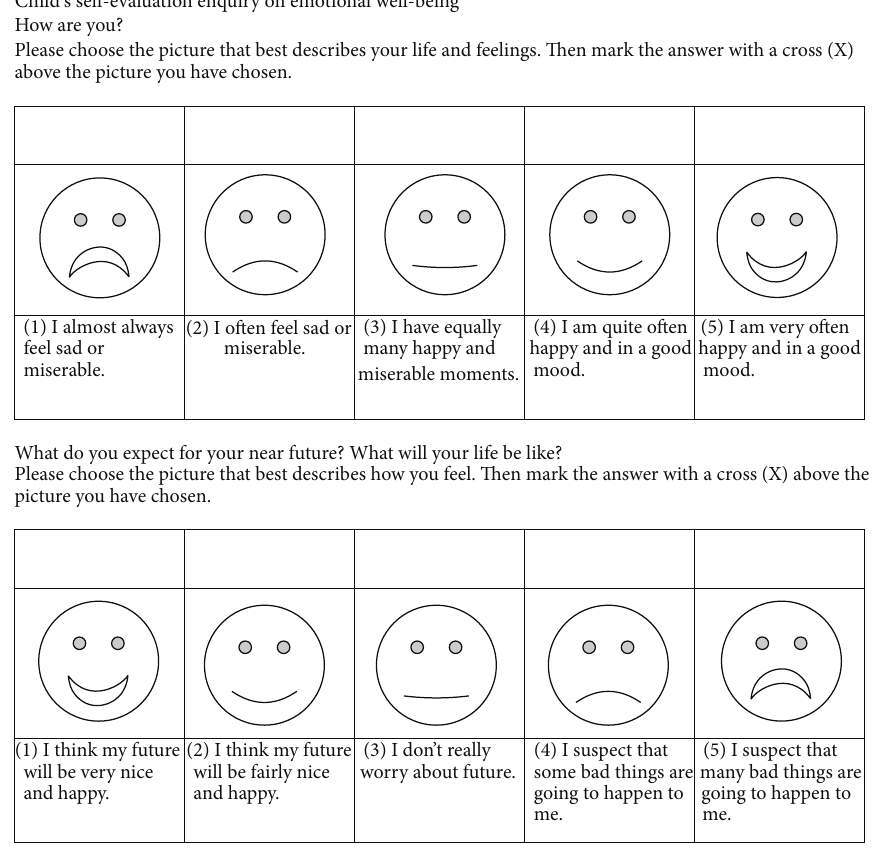
Figure 1: Child’s self-evaluation enquiry on emotional